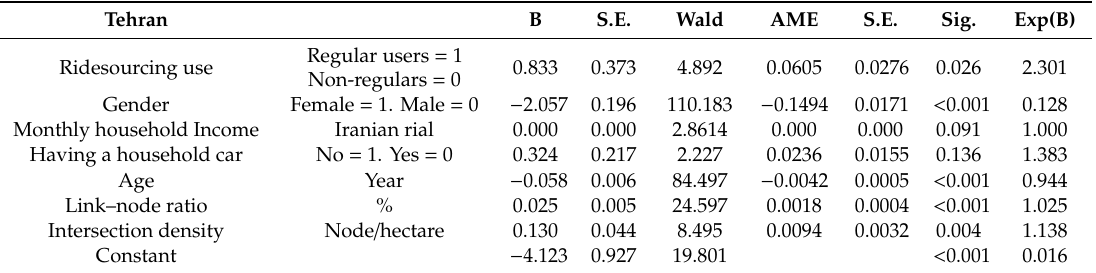
Table 3. Binary logit regression for cycling to near destination in